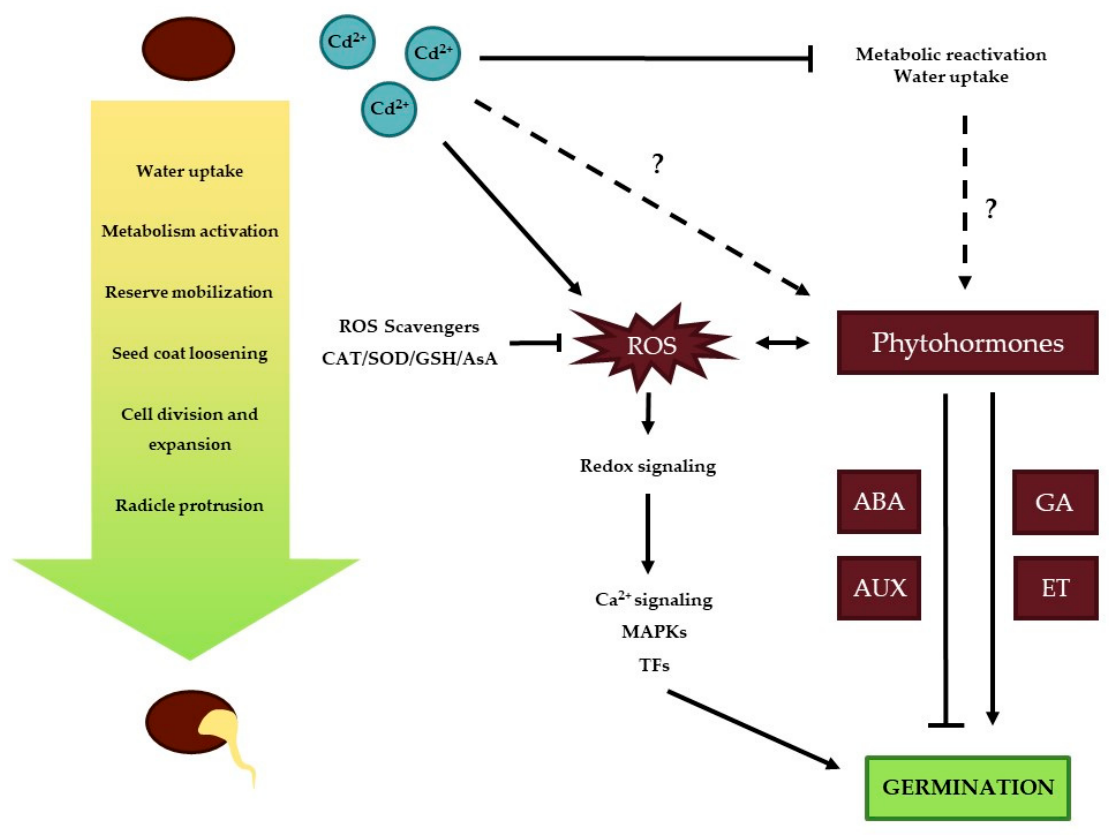
Figure 1. Possible interference mechanisms of cadmium on the process of seed germination. Cadmium (Cd) negatively affects metabolic reactivation by reducing levels of hydrolyzing enzymes, starch mobilization and seed imbibition. Furthermore, it can alter redox signaling via calcium (Ca), mitogen-activated protein kinases (MAPKs) and transcription factors (TFs) and the level of phytohormones such as abscisic acid (ABA), auxin (AUX), giberrellic acid (GA) and ethylene (ET). Both are of major importance in the seed germination process. One-way arrows: indicate a stimulating effect, whereas T-shaped arrows represent an inhibitory effect. Two-way arrows signify an interaction and dashed lines indicate effects which are still uncertain.